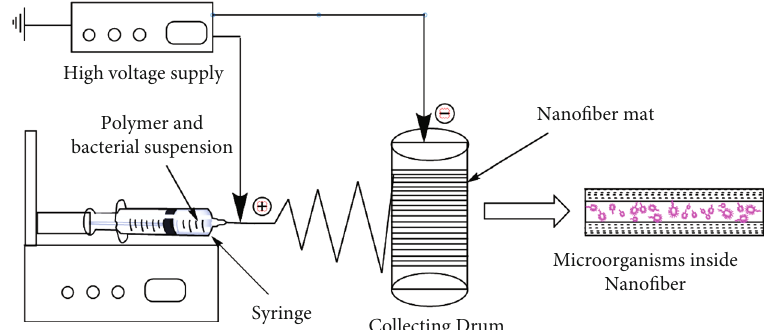
Figure 2: Electrospinning machine